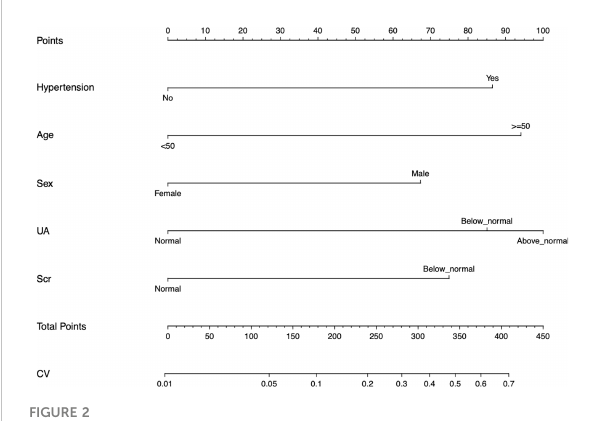
FIGURE 2 Developed the predictive nomogram of diabetes mellitus in IIMs patients. The predictive nomogram was developed in the cohort, with the age, gender, hypertension, uric acid (UA), and serum creatinine (Scr)